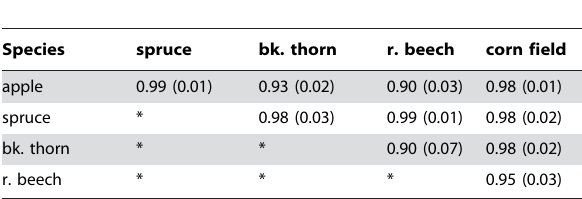
Table 2. Area under the ROC curve for the ten classification tasks of one species vs. another one.